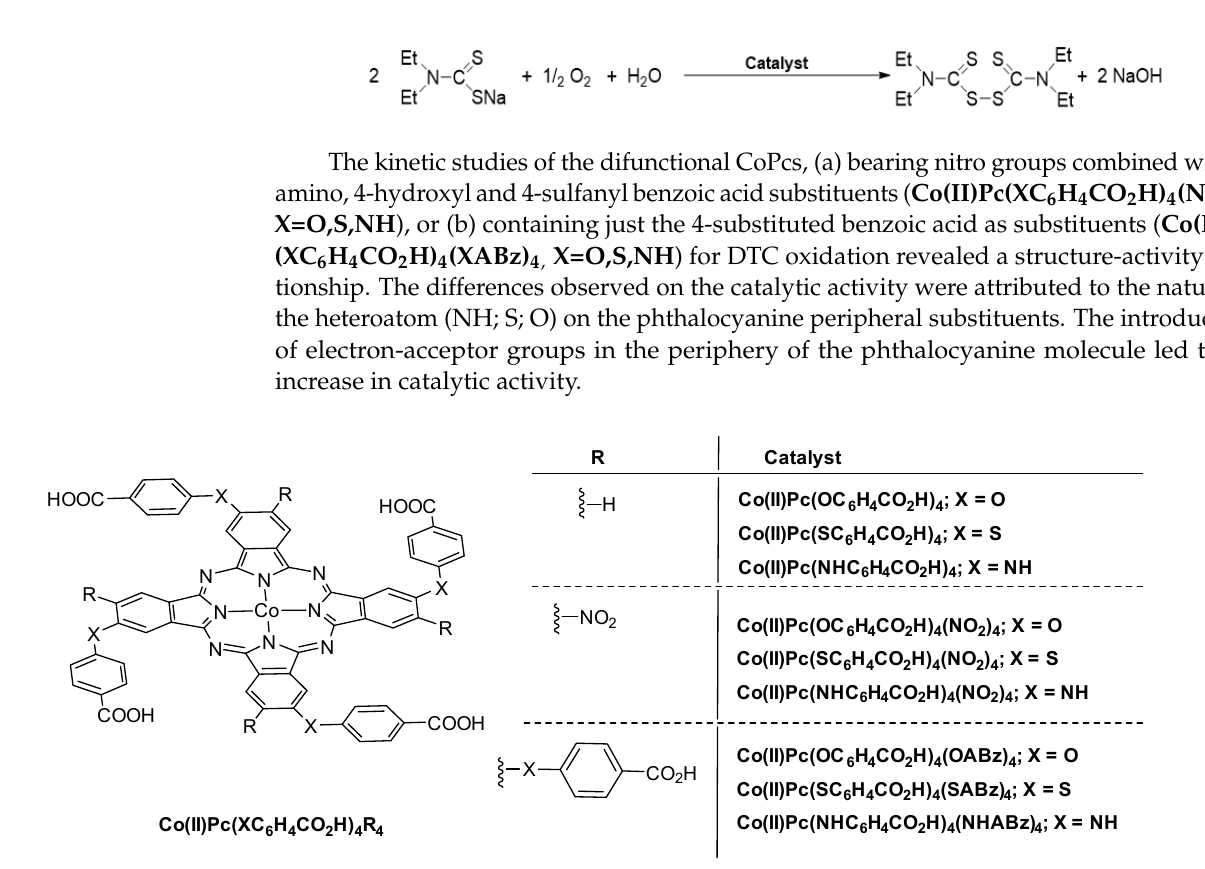
Figure 12. Structures of cobalt(II) complexes with tetrasubstituted phthalocyanines bearing nitro groups and benzoic acid groups.